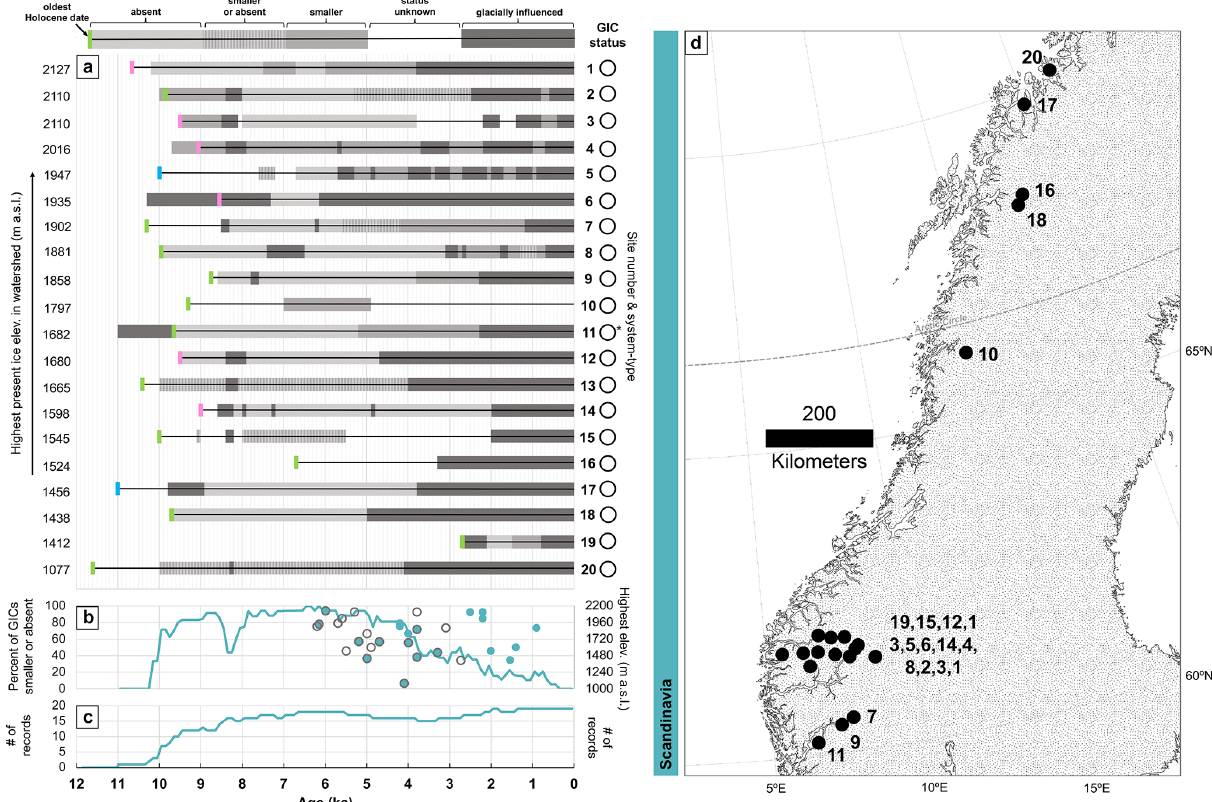
Figure 7. Holocene lake-based GIC records from Scandinavia. Panel descriptions, symbols, and colors are the same as in Fig. 3. Sites are as follows: 1. Lie et al. (2004) (Lake Bukkehåmmårtjørna, Bukkehåmmårbreen); 2. Matthews et al. (2000) (Bøvertunsvatnet Lake, Leirbreen); 3. Matthews et al. (2000) (Dalsvatnet Lake, Liabreen and Høybreane glaciers); 4. Shakesby et al. (2007) (Liavatnet Lake, Sekkebreen, Tver- rbyttnbreen, Kupenbreen, Kupbreen, Tverreggibreen, Greinbreen, Tverrbotnbreeen, Harbardsbreeen, and Fortundalsbreen); 5. Vasskog et al. (2012) (Lake Nerfloen, numerous glaciers (presently 52) including five outlet glaciers of Jostedalsbreen); 6. Nesje et al. (2000) (Ne- dre Sygneskardvatnet Lake, Sygneskardbreen); 7. Dahl and Nesje (1994, 1996) (Lake Hestebotnvatn and Tungevatn, N Hardangerjøkulen Glacier); 8. Karlén and Matthews (1992), Matthews and Karlén (1992) (Gjuvvatnet Lake, unnamed glacier); 9. Nesje et al. (1994) (Lake Is- dalsvatn, SW Hardangerjøkulen Glacier); 10. Bakke et al. (2010) (Vestre and Austre Kjennsvatnet lakes, Austre Okstindbreen); 11. Bakke et al. (2005b, c) (Dravladalsvatn, Vassdalsvatn, and Vetlavatn lakes, N Folgefonna glaciers); 12. Seierstad et al. (2002) (Lake Grøningstølsvatnet, Grovabreen); 13. Nesje et al. (2001) (Lake Jarbuvatnet, Flatebreen); 14. Nesje et al. (2006) (Lake Vanndalsvatnet, Spørteggbreen); 15. Bakke et al. (2013) (Lake Nedre Sørsendalsvatn, Blåbreen); 16. Snowball and Sandgren (1996) (Bajimus Gorsajávri, Vuolimus Gorsajávri, and Gaskkamus Gorsajávri lakes, Kårsa Glacier); 17. Bakke et al. (2005a) (Lake Aspvatnet, Lenangsbreene); 18. Rosqvist et al. (2004) (Vuolep Allakasjaure Lake, unnamed glacier); 19. Nesje et al., 1995) (Lake Grøndalsvatn, Ålfotbreen); 20. Wittmeier et al. (2015) (Jøkelvatnet, Store Rundvatnet, and Storvatnet lakes, Langfjordjøkelen Ice Cap). Glacier elevations for Shakesby et al. (2007) were estimated via the ASTER GDEM due to data holes in the ArcticDEM. ∗ Record 11 combines multiple glacial lakes. We note that Vetlavatn Lake only receives glacial sediments when the glacier advances beyond a local bedrock threshold and is therefore considered to be glacier–lake system type 2, while the other two lakes are system type